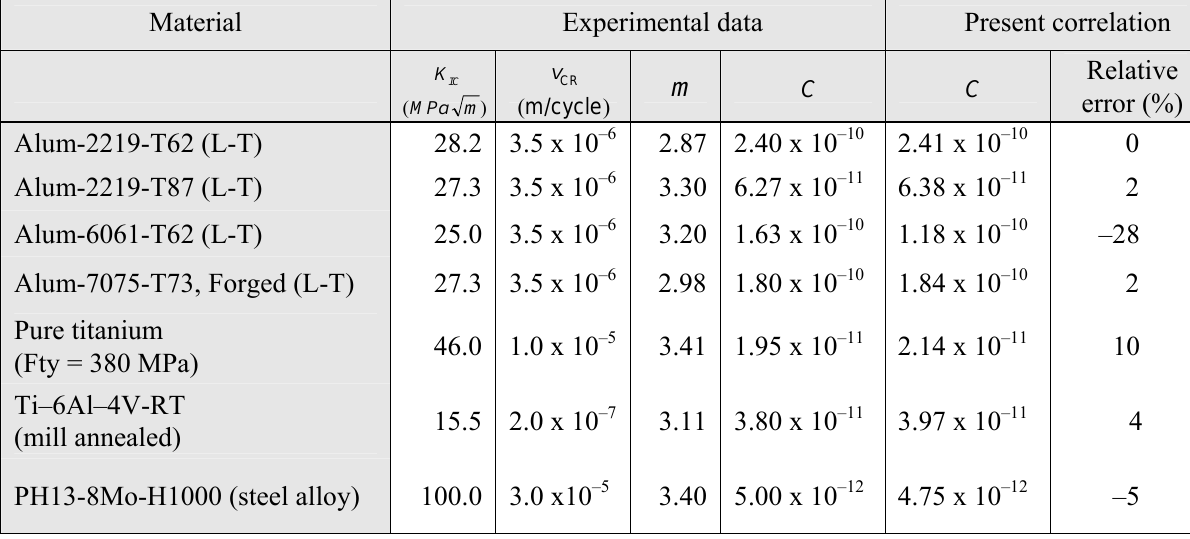
Table 2. Experimental assessment of the proposed correlation for aluminium, titanium and steel alloys according to the NASGRO database